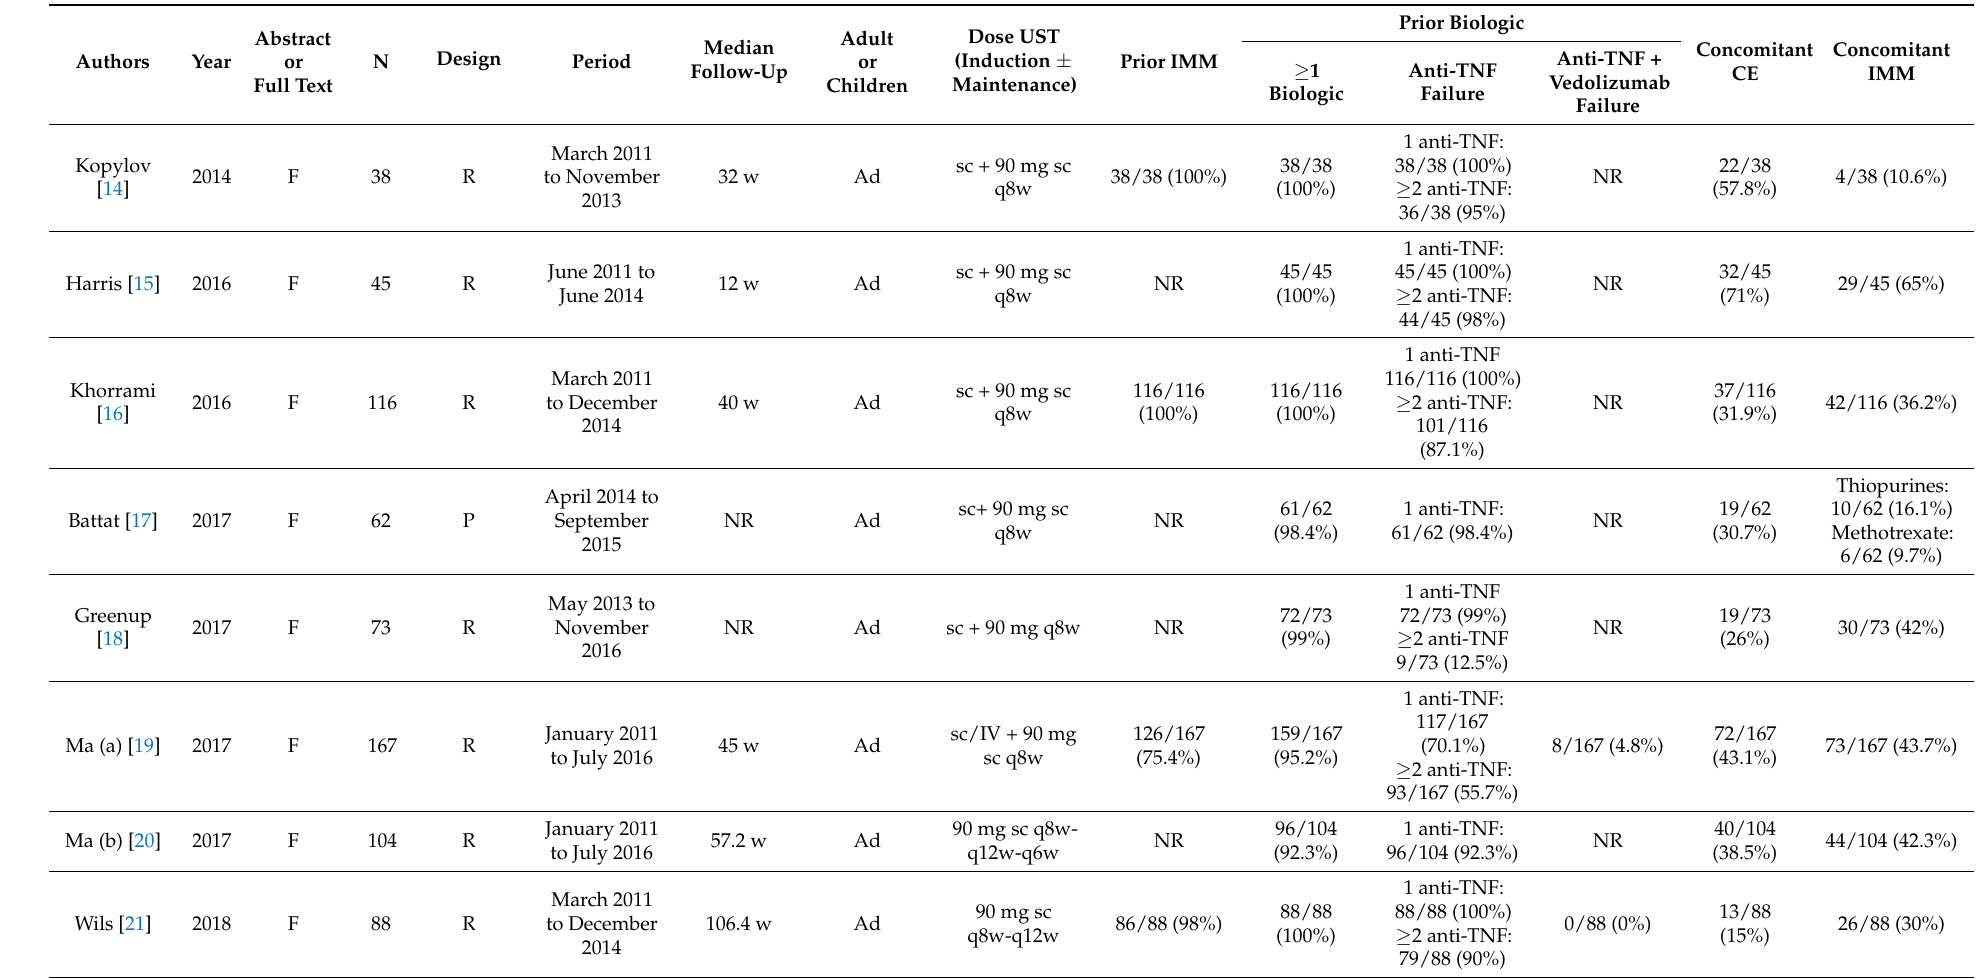
Table 1. Baseline characteristics of the studies included in the